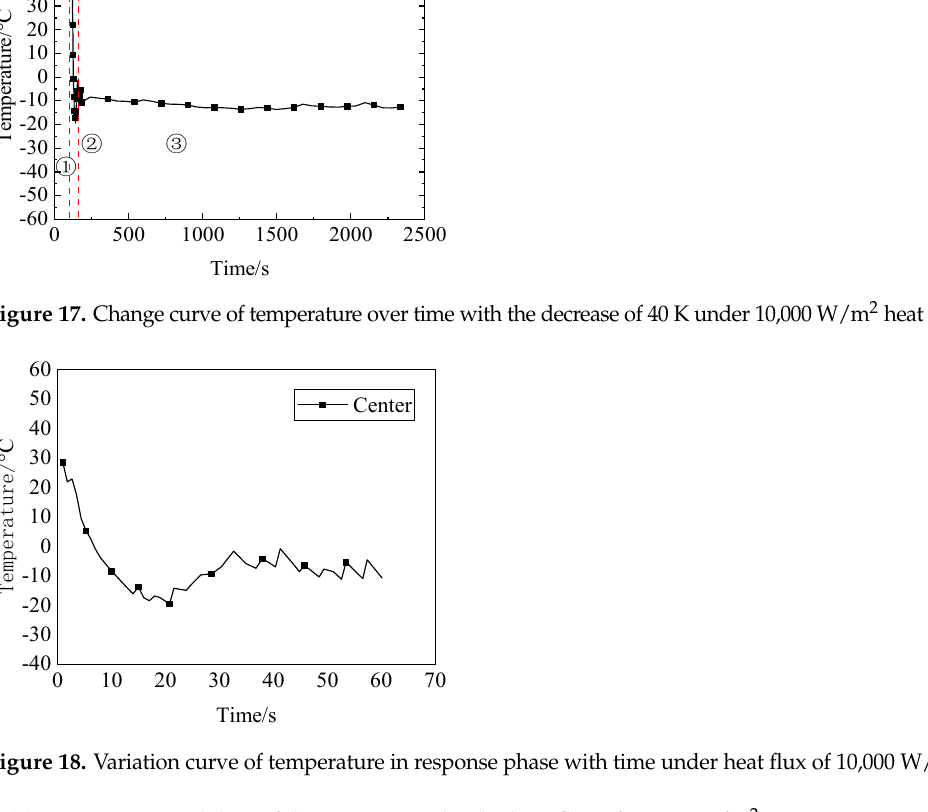
Table 9. Experimental data of three stages under the heat flux of 10,000 W/m 2